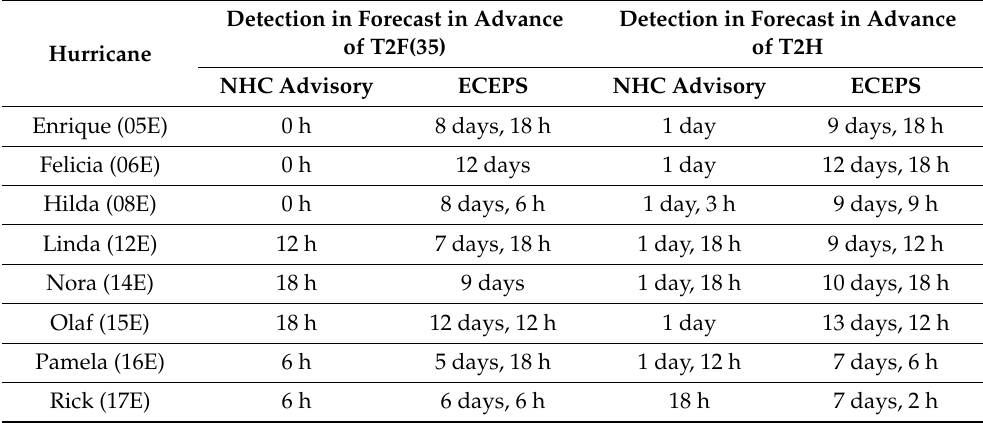
Table 5. Comparison of the first detection times in advance of the T2F(35) and the T2H of the pre- Hurricane disturbances from the first NHC advisories versus from the ECEPS pre-formation forecasts. Detection in Forecast in Advance Detection in Forecast in Advance of T2F(35) of T2H Hurricane NHC Advisory ECEPS NHC Advisory